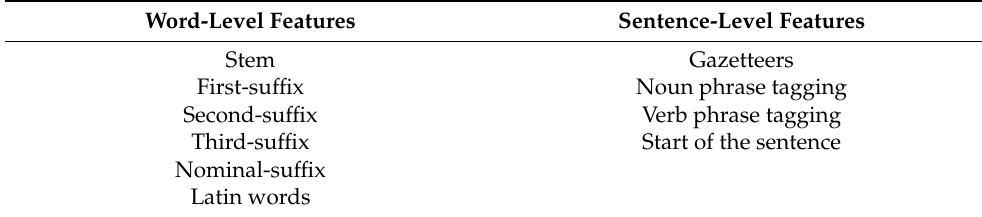
Table 5. Multi features of the Kazakh language.